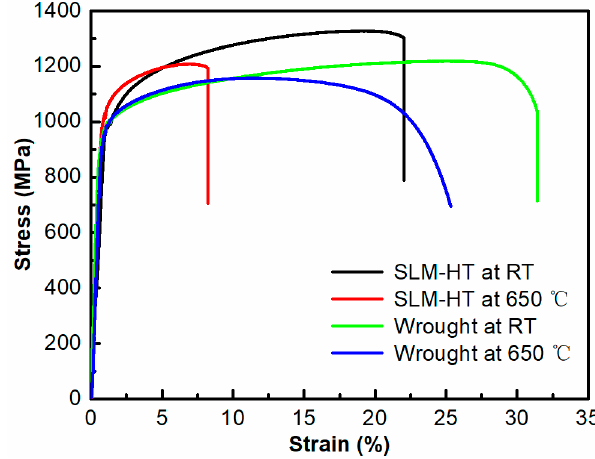
Figure 5. Tensile stress-strain curves of SLM-HT and wrought IN718 specimens tested at RT and 650 °C. The tensile curves of SLM alloy at RT and wrought material at 650 °C are cited from the